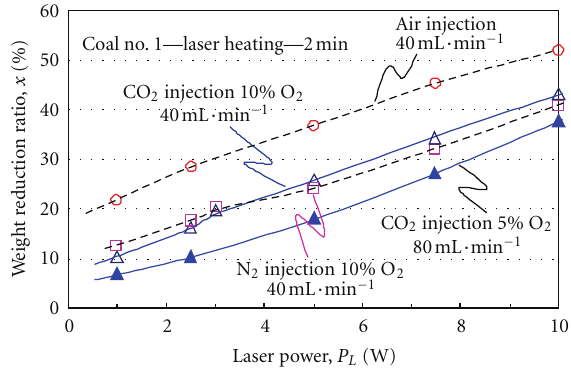
Figure 8: Comparison of weight reduction ratio, x (%) with di ff erent gases injection.